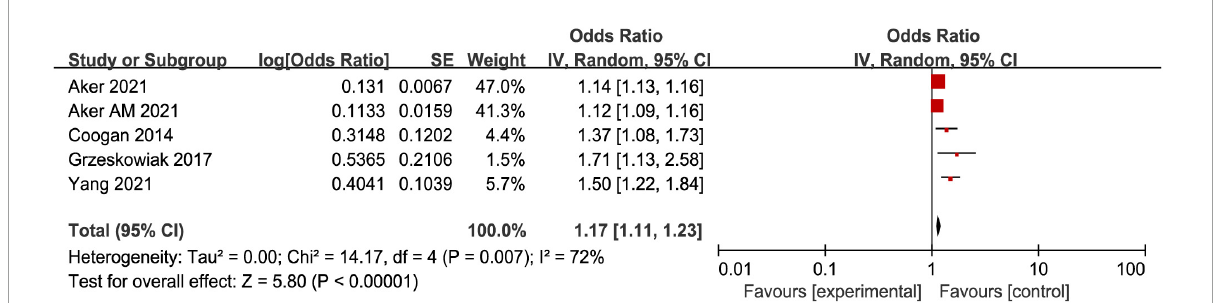
FIGURE3 Forest map of association meta-analysis between AD and MD—Only relatively high-quality studies were included.